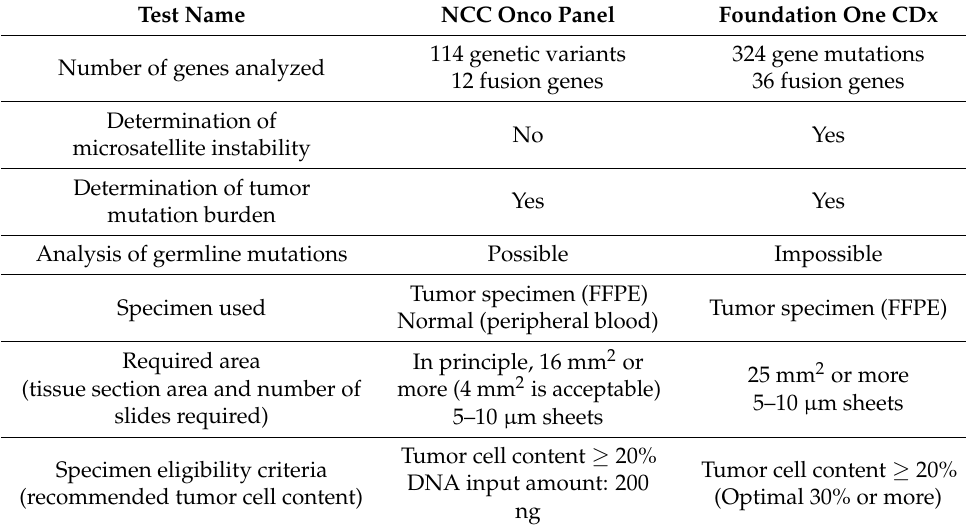
Table 1. Differences between two cancer gene panel